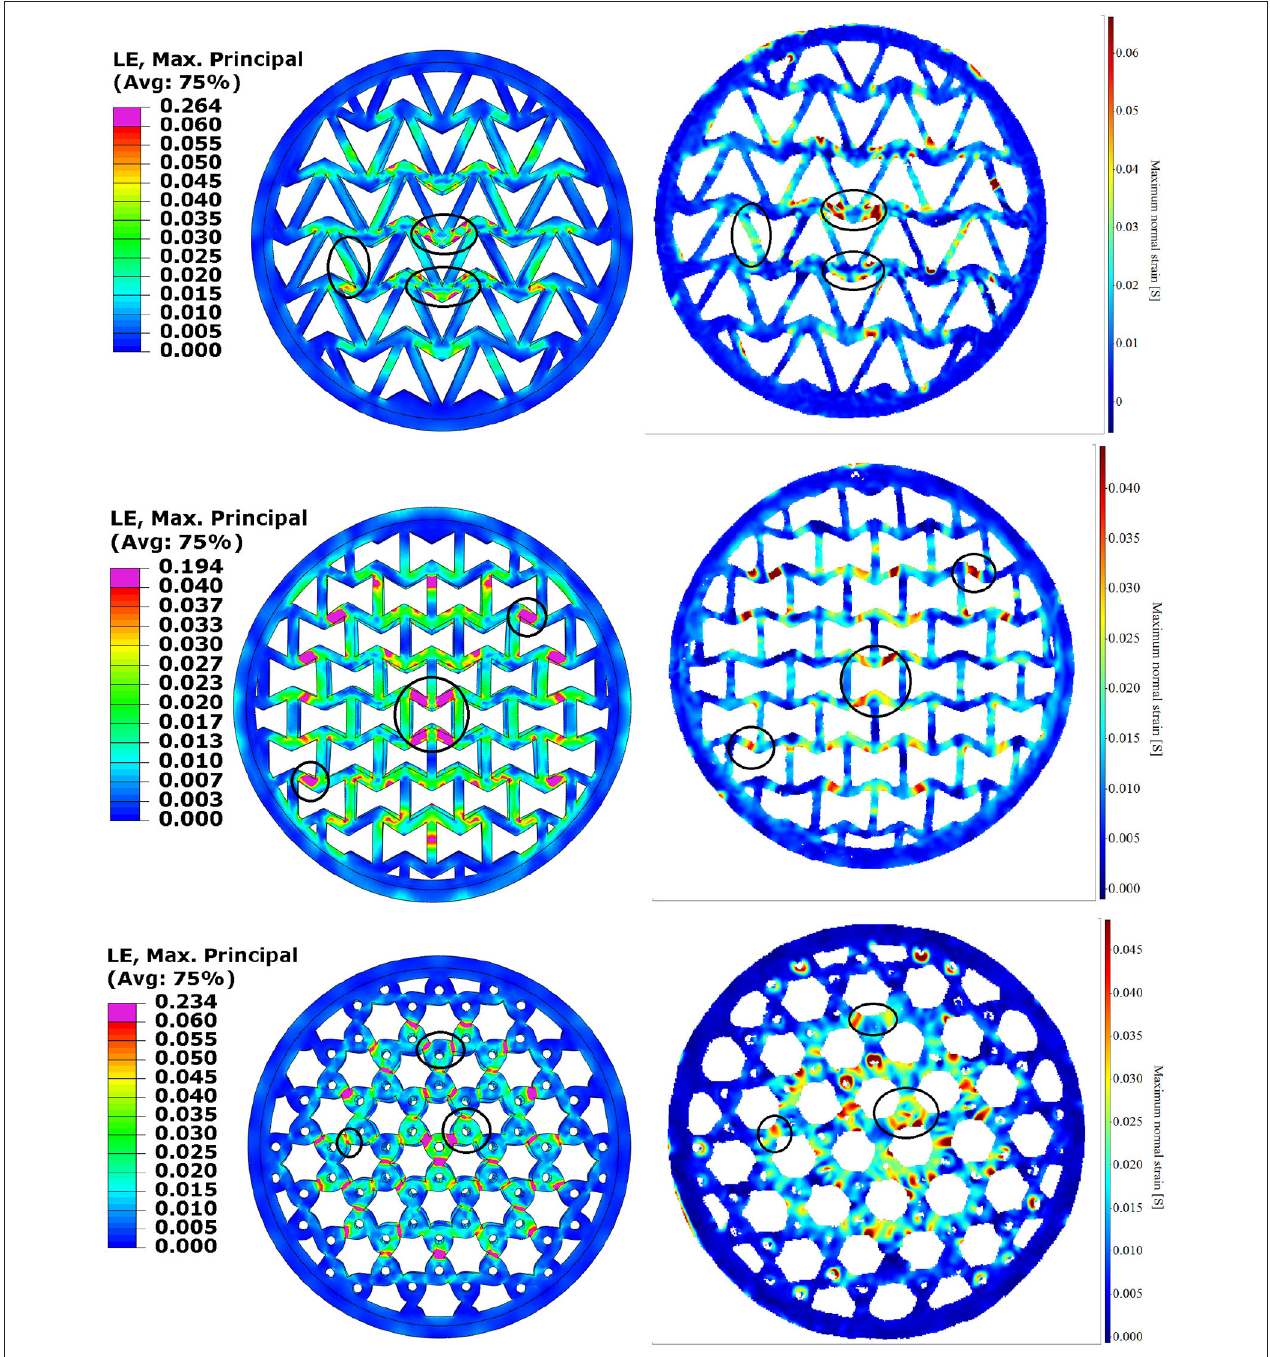
FIGURE 11 | FE (Left) vs. DIC (Right) ǫ 1 at buckling for 3 topologies: arrow-head in the top row, re-entrant in the middle row and tri-chiral in the bottom row. The most interesting features have been circled.